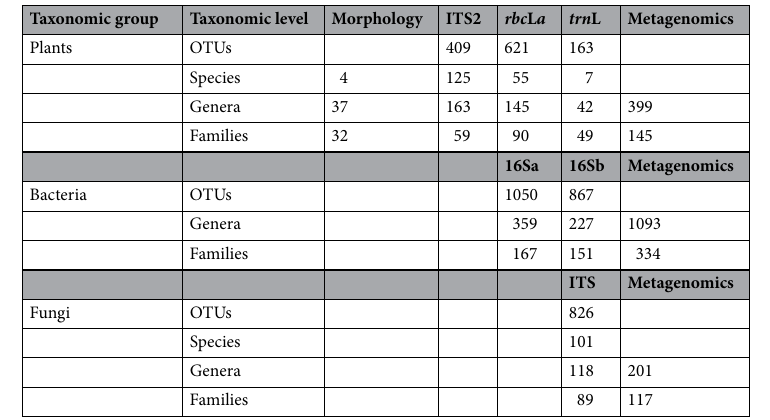
Table 1. Number of taxa identified by different methods. For metabarcoding of plants, we used gene regions ITS2, rbc L a and trn L, for metabarcoding of bacteria we used the 16S rRNA gene region with two primer sets (16Sa and 16Sb), and for metabarcoding of fungi we used ITS. Note that for the number of OTUs, the OTUs from both non-filtered and filtered samples are